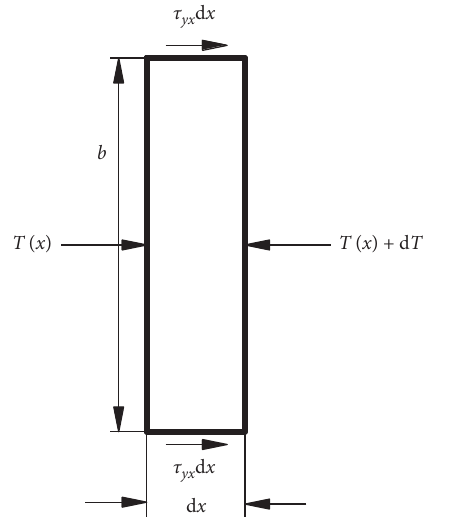
Figure 3: Simplified mechanical model of coal